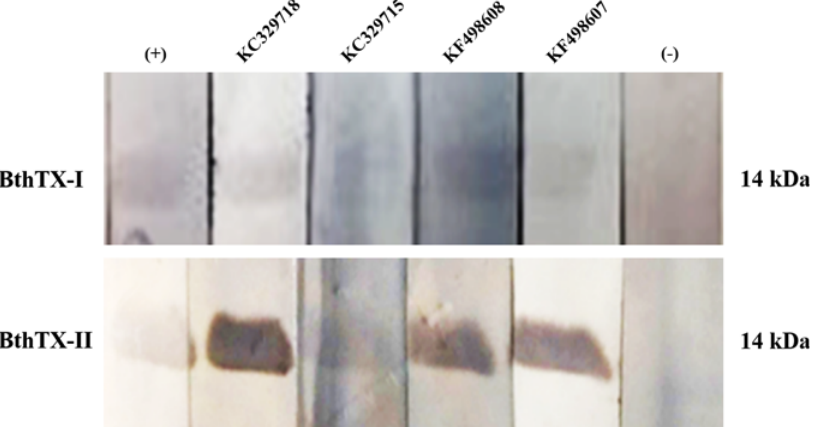
Fig 3. Western blot of purified VHHs against BthTX-I. 15% SDS-PAGE was carried out to resolve BthTX-I and BthTX-II under reducing conditions. After electrophoresis, BthTX-I and BthTX-II were